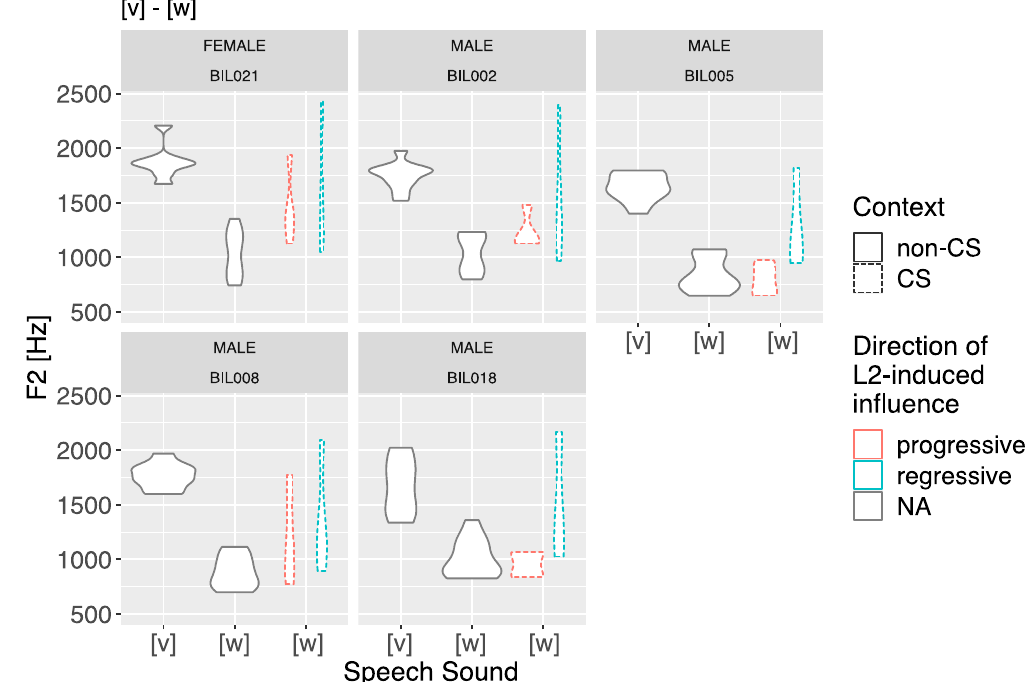
Figure 3. F2 of intended [v] and [w] sounds in English words, spoken by 5 (one female, four male) BIL speakers in non-CS (black), and of [w] in CS (colored) environments, with the latter being divided into contexts with possible progressive (red) and regressive (green) L2-induced influences. Only speakers with significant differences are presented. For the sake of a better presentation of potentially multimodal (and therefore non-normal) distributions of the data, we opted for violin plots instead of boxplots, because a violin plot shows the full distribution of the data as rotated kernel density plots on both sides.